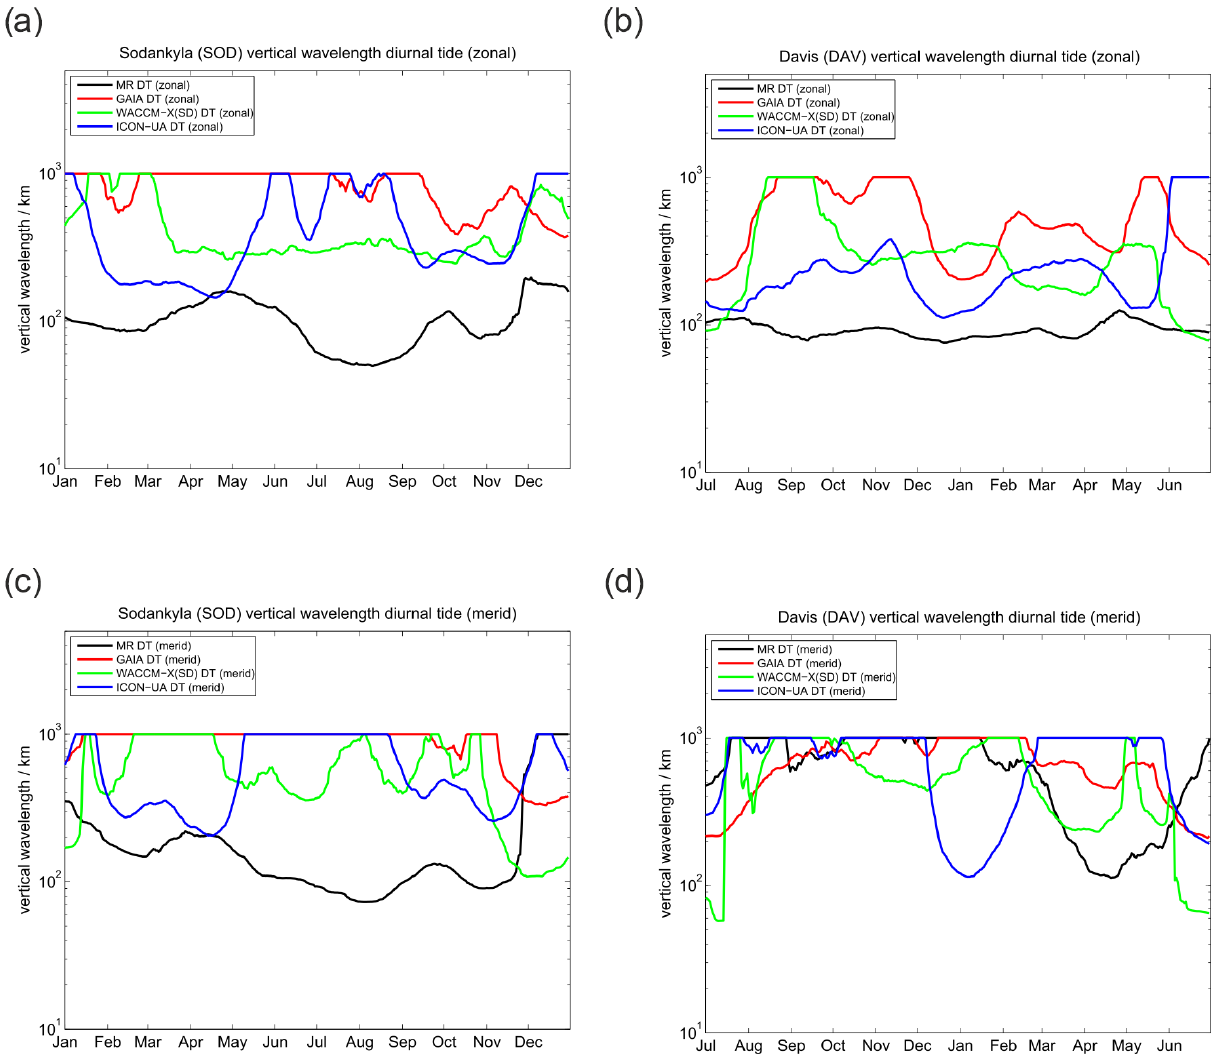
Figure 5. Comparison of vertical wavelengths of the diurnal tide. The left column shows (a) the zonal and (c) meridional vertical wavelength for SOD. Panels (b) and (d) present the same but for